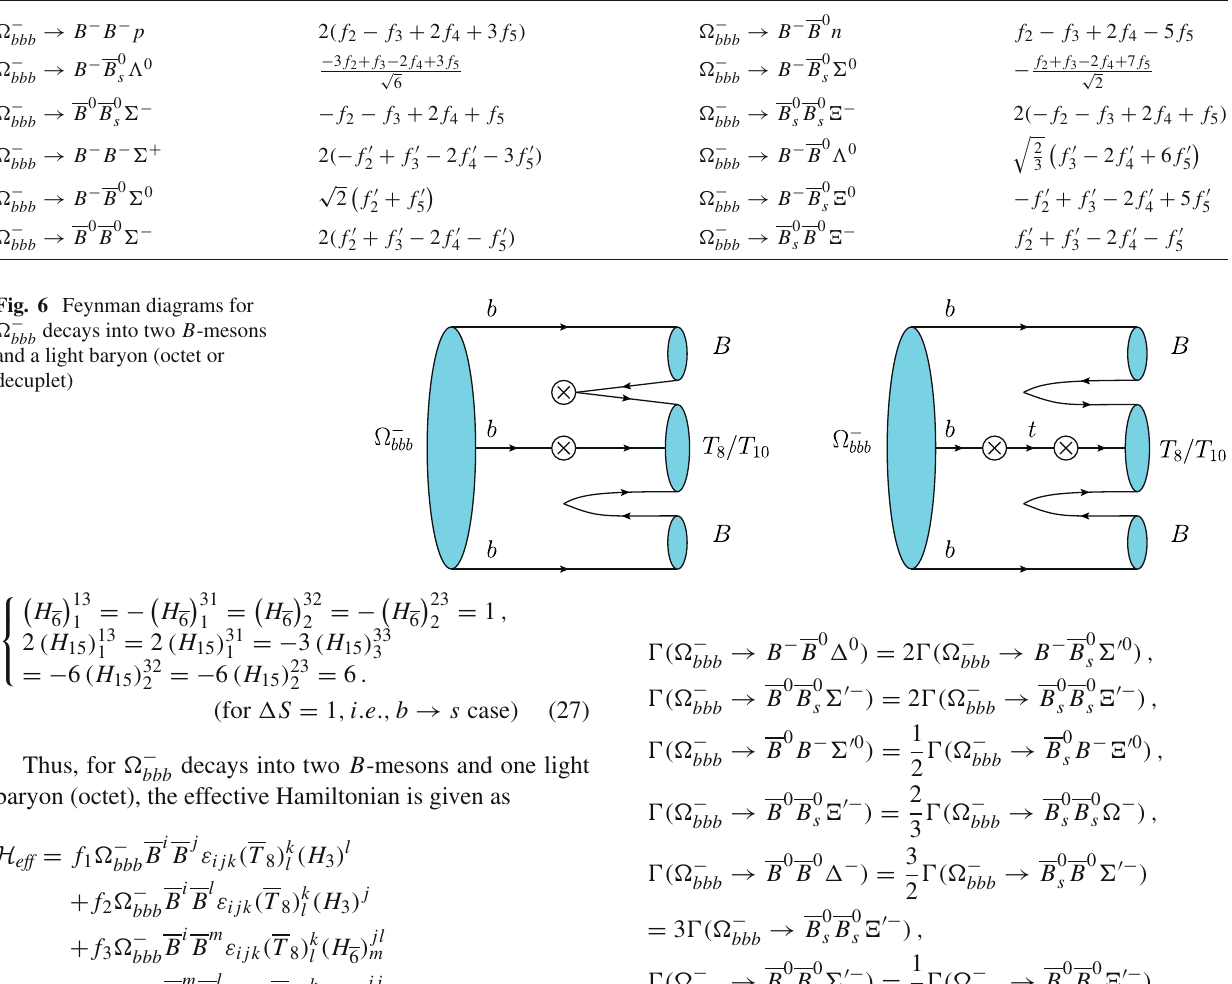
Table 7 Amplitudes for (cid:2) − decays into two B -mesons and a light baryon (octet) bbb Channel Amplitude Channel